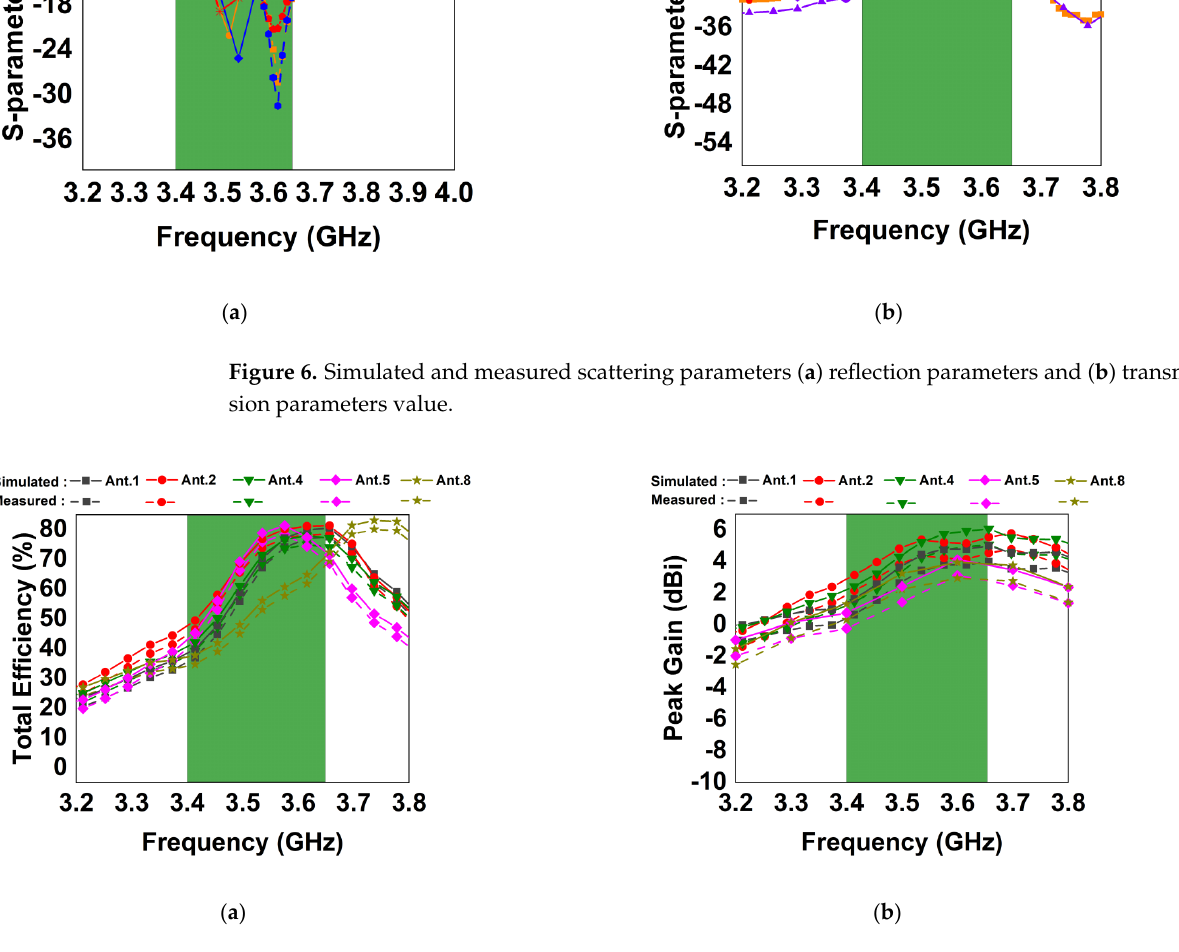
Figure 7. Measured ( a ) antenna total efficiency and ( b ) antenna gain.